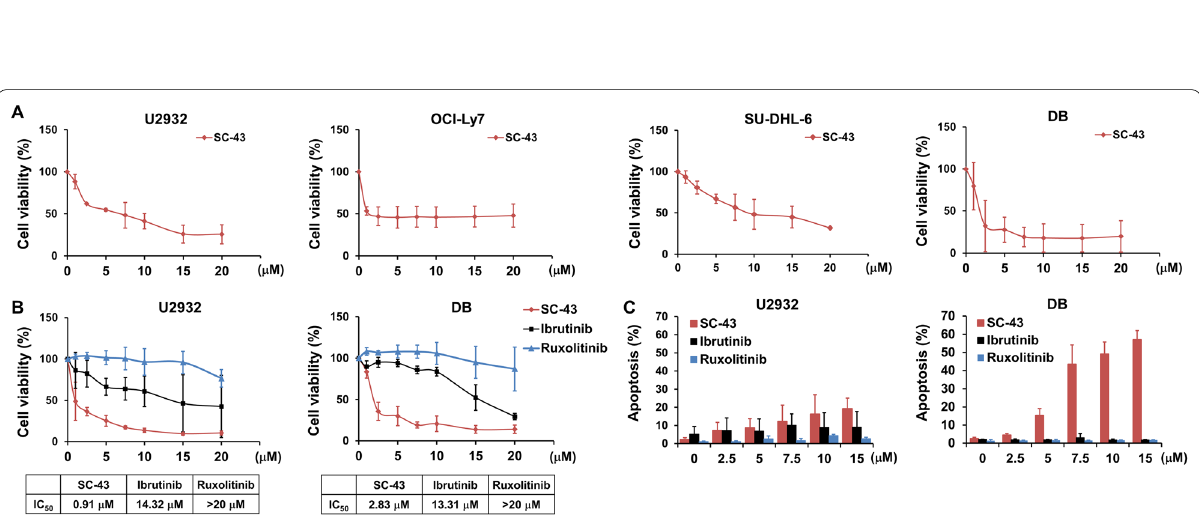
Fig. 3 SHP‑1 agonist shows anti‑proliferation activity. A DLBCL cells treated with SC‑43 at the indicated doses for 72 h were assessed by MTT assay. B U2932 and DB cells treated with SC‑43, ibrutinib or ruxolitinib at the indicated doses for 72 h were assessed by MTT assay. C U2932 and DB cells treated with SC‑43, ibrutinib or ruxolitinib at the indicated doses for 48 h were analyzed by flow cytometry. Data are representative of three independent